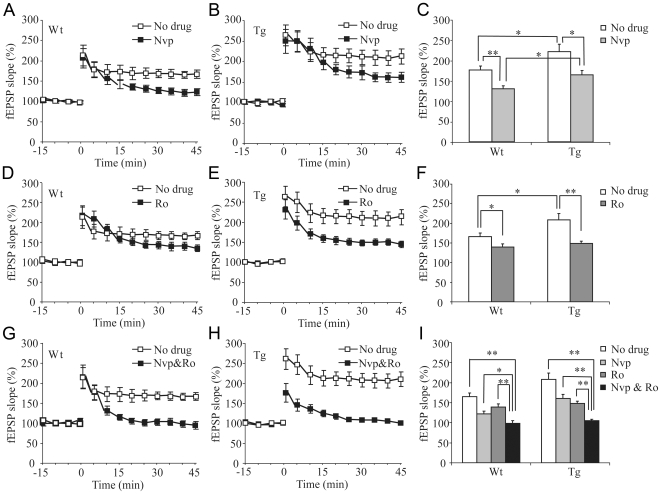
The Role of NR2B Subunit in Enhanced CA1-LTP in Transgenic Hippomcampal Slices.A: Effects of NR2A-selective antagonist, NVP-AAM077, on wild-type slices. B: NVP-AAM077 also significantly reduced, but not completely blocked, CA1 LTP in transgenic slices. C: Statistical analysis shows the effects of NVP-AAM077 on LTP in both Tg and Wt slice. It indicates a significant involvement of NR2A-containing NMDARs in CA1-LTP induction in both Tg and WT slices. D: There was a significant, but small, effect of NR2B-selective antagonist, Ro25-6981, on CA1-LTP in wild-type slices. E: Ro25-6981 had much larger effect on CA1-LTP in transgenic slices, but it did not completely block LTP in transgenic slices. F: Summarized effects of Ro25-6981 on CA1-LTP in both Tg and Wt slice. G: Combination of NVP-AAM077 and Ro25-6981 completely blocked the formation of CA3-CA1 LTP completely in the wild-type slices. H: Complete blockage of CA1-LTP in transgenic slices by combined application of NVP-AAM077 and Ro25-6981. I: Statistical analysis shows the combined effects of NVP-AAM077 and Ro25-6981 on CA1-LTP. (Data were presented as the mean±SEM. Student's t-test was used for statistical analysis).